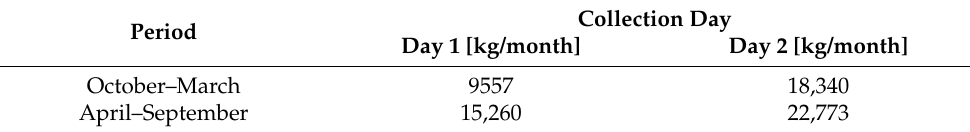
Table 4. Average amount of food waste collected per month in De Pinte